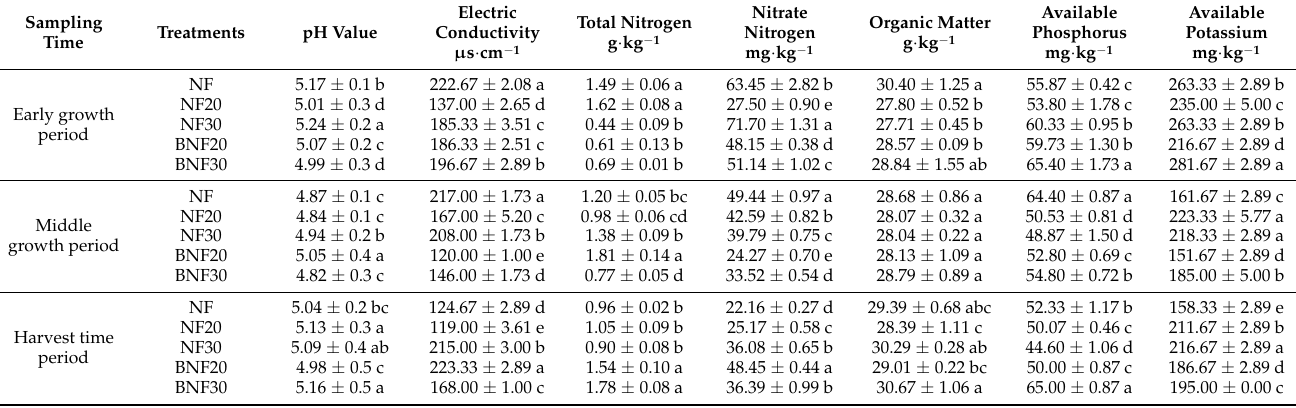
Table 2. Effects of different treatments on chemical characteristics on rhizosphere soil of ‘yellow rose’ cabbage. Sampling Time Treatments